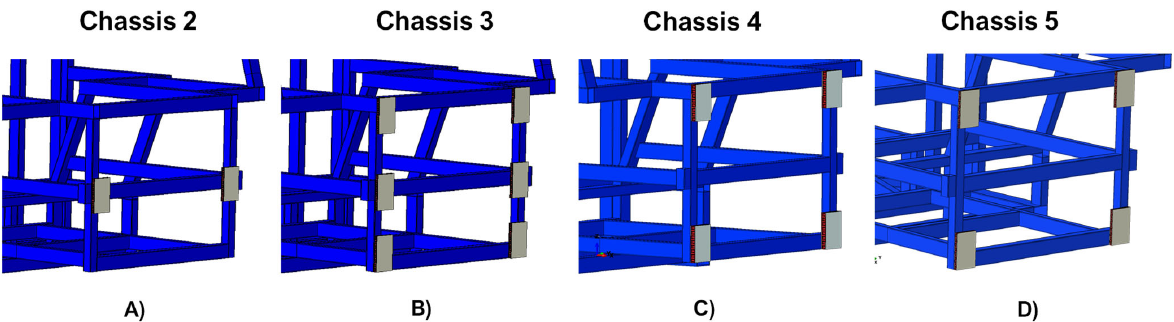
Figure 4. Chassis ‐ damping systems interaction zone. ( A ) Chassis 2, ( B ) Chassis 3, ( C ) Chassis 4, and ( D ) Chassis 5.